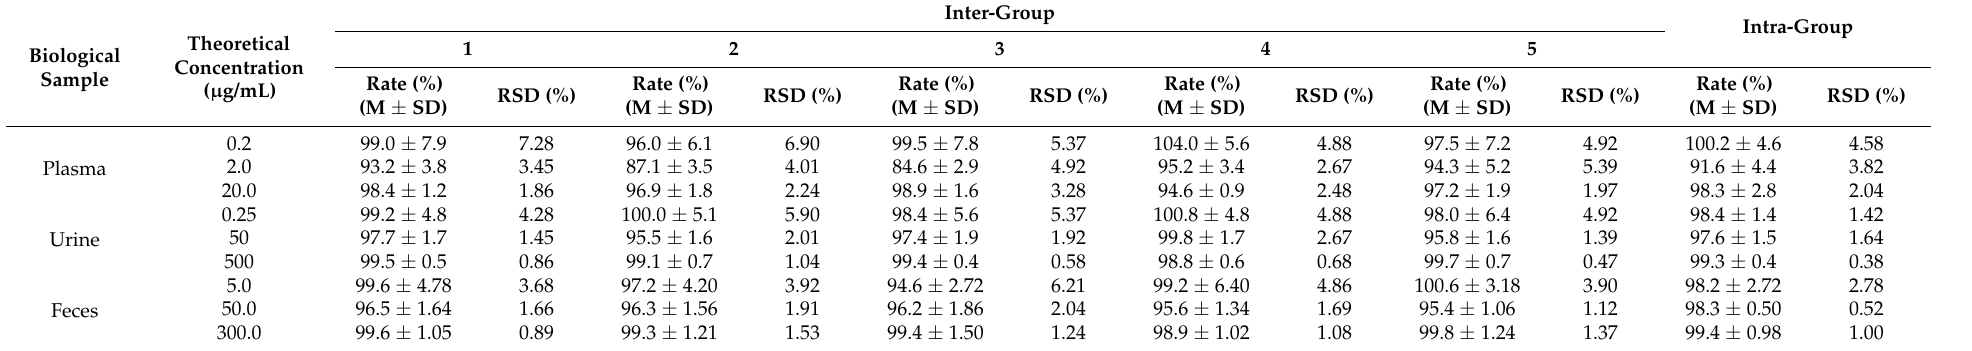
Table 3. Inter- and intra-group matrix effect and extraction recovery for LBP-FITC in rat plasma, urine, and feces ( n = 5).